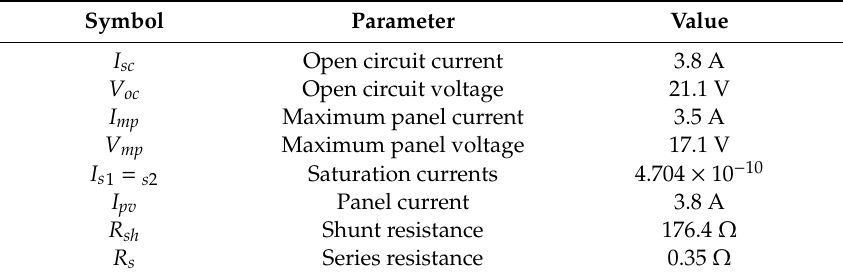
Table 1. Parameters of the PV array [33].